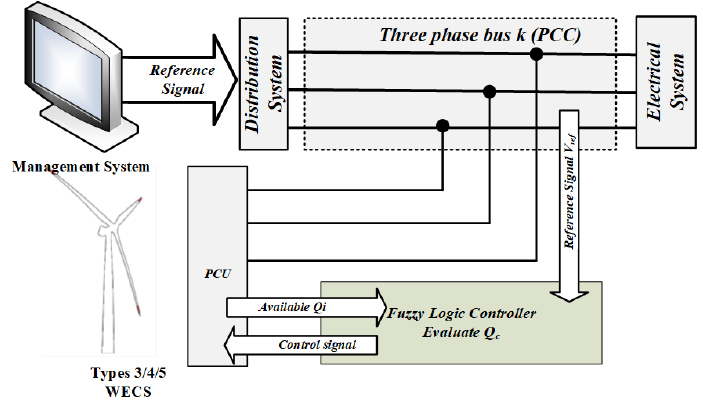
Figure 2. Reactive power compensation of inverter-based WECS.